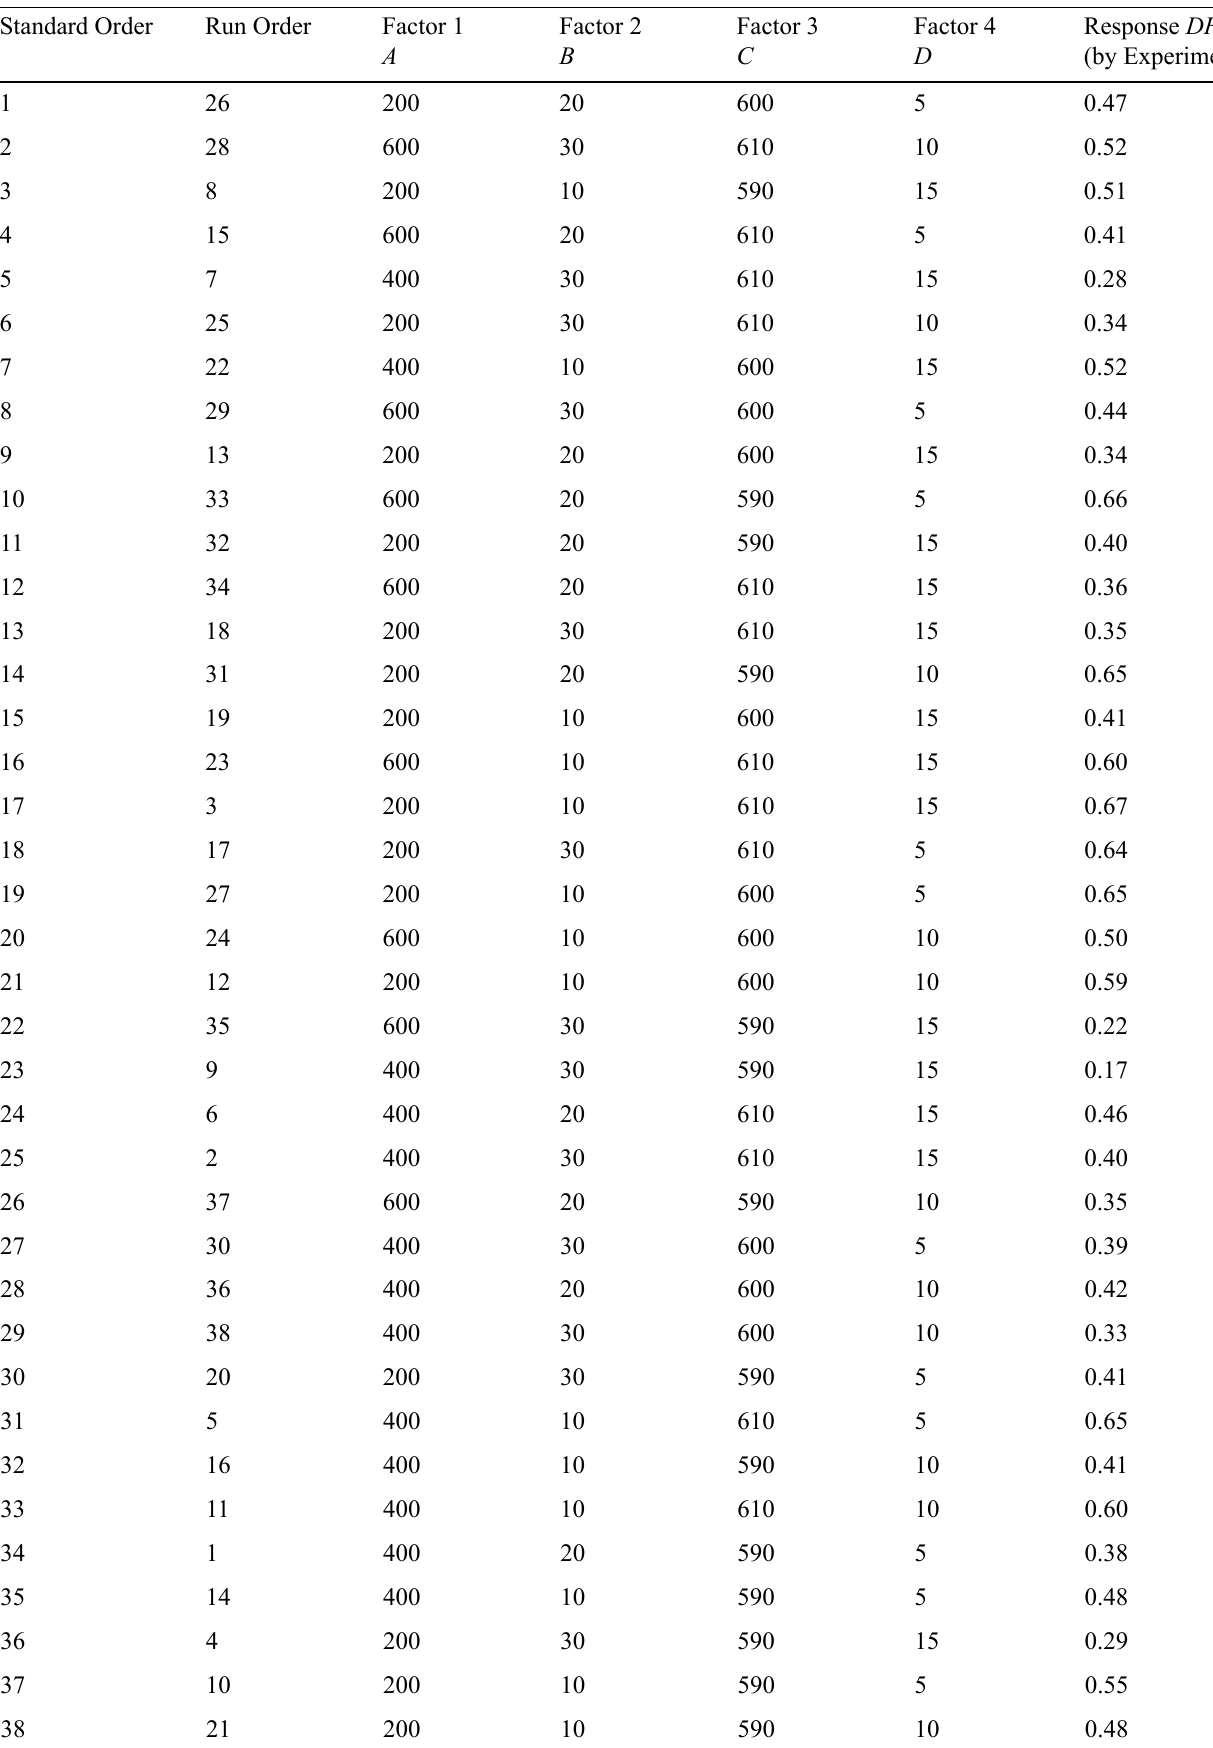
Table 3. DODE tests and the response for compocasting